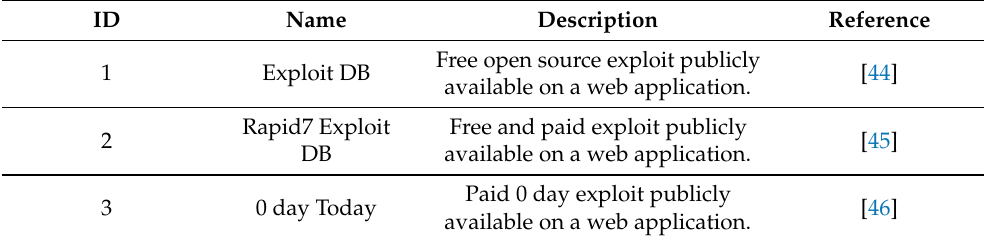
Table 7. Tools used for OSINT on exploit databases.